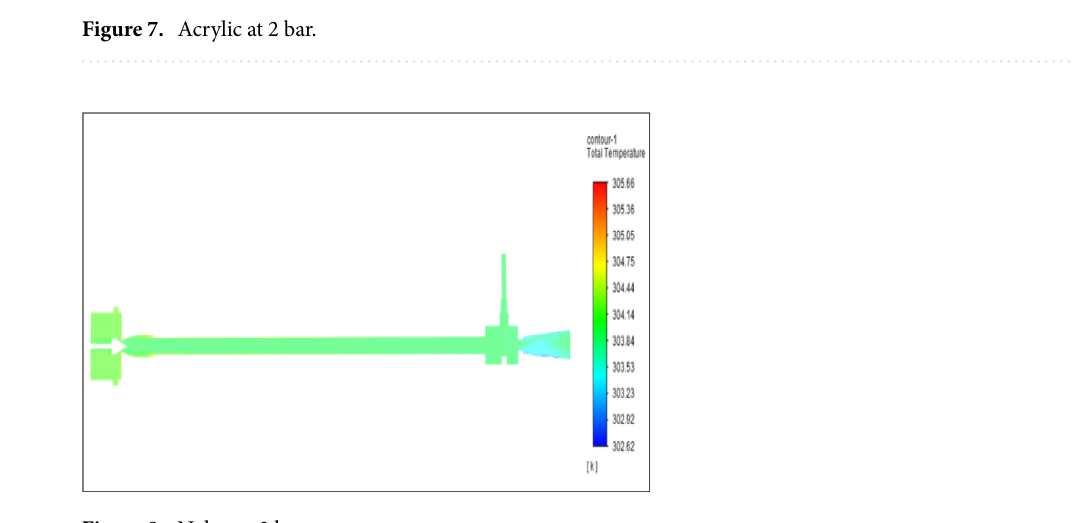
Figure 8. Nylon at 2